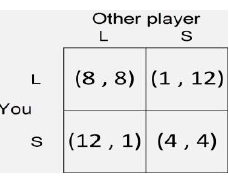
Figure 2. The two types of eye cues, kind eyes ( A ) and unkind eyes ( B ), and the control cue ( C ).